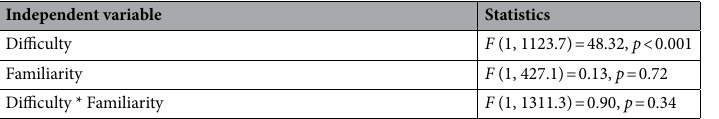
Table 3. Results of the GLMM (a Generalized Linear Mixed Model). * indicates the interaction term.